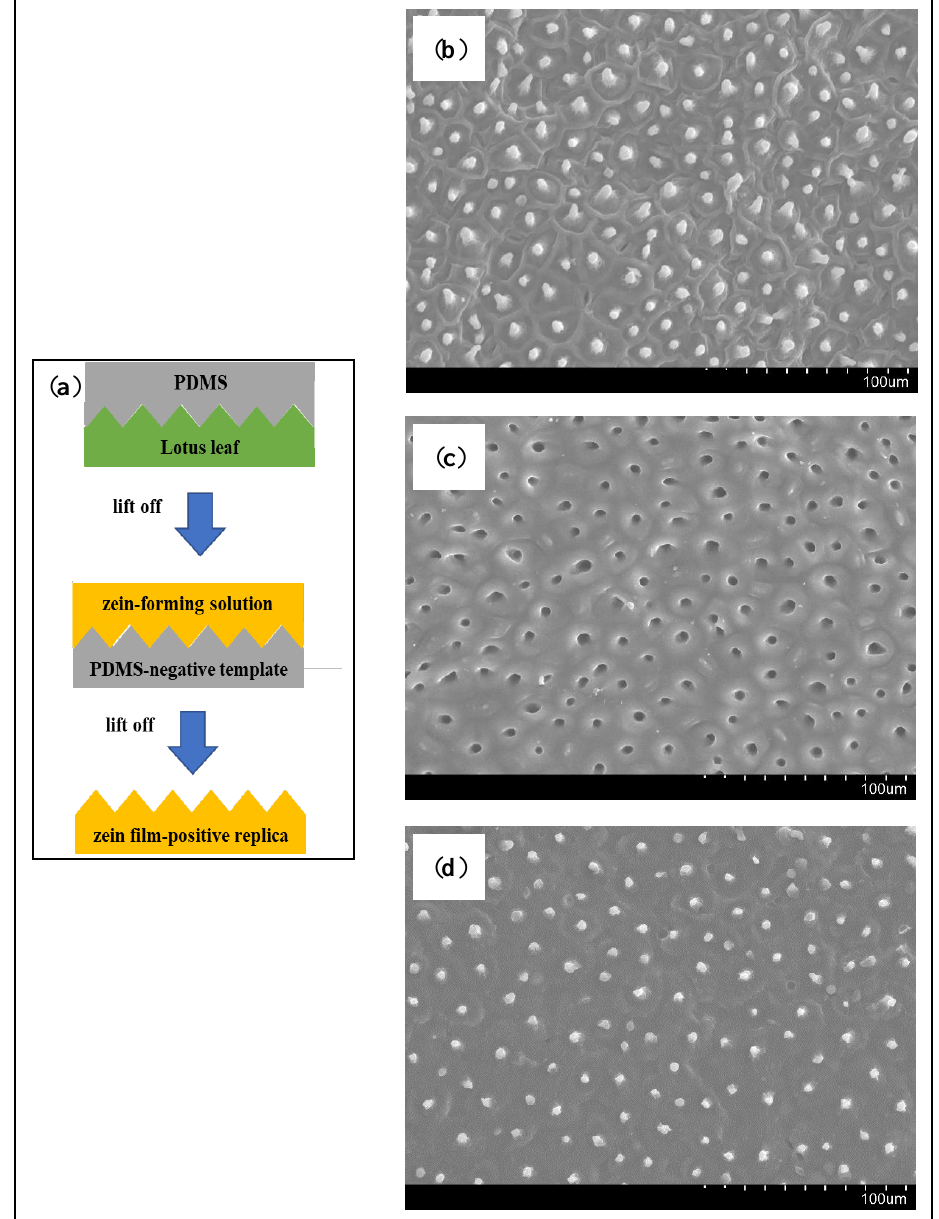
Figure 1. Flowchart for negative template fabrication and films preparation ( a ). SEM images of lotus leaf surface ( b ), PDMS-negative template ( c ), and zein film-positive replica ( d ). (Magnification: 500×).